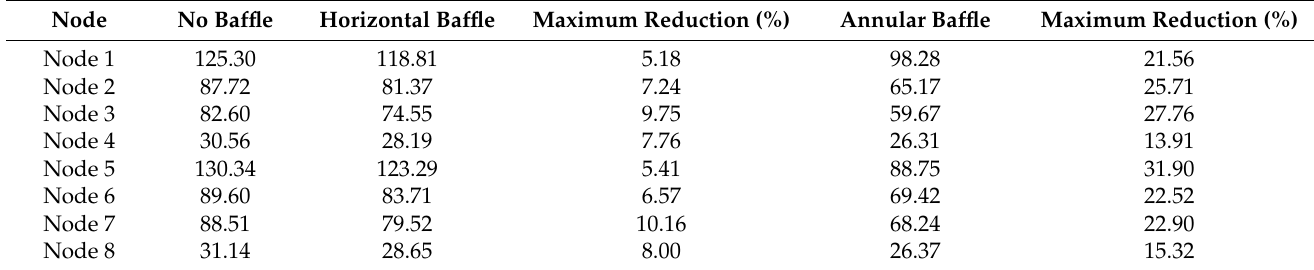
Table 6. Base shear (KN) maximum percentage reduction in a rigid elevated storage tank.